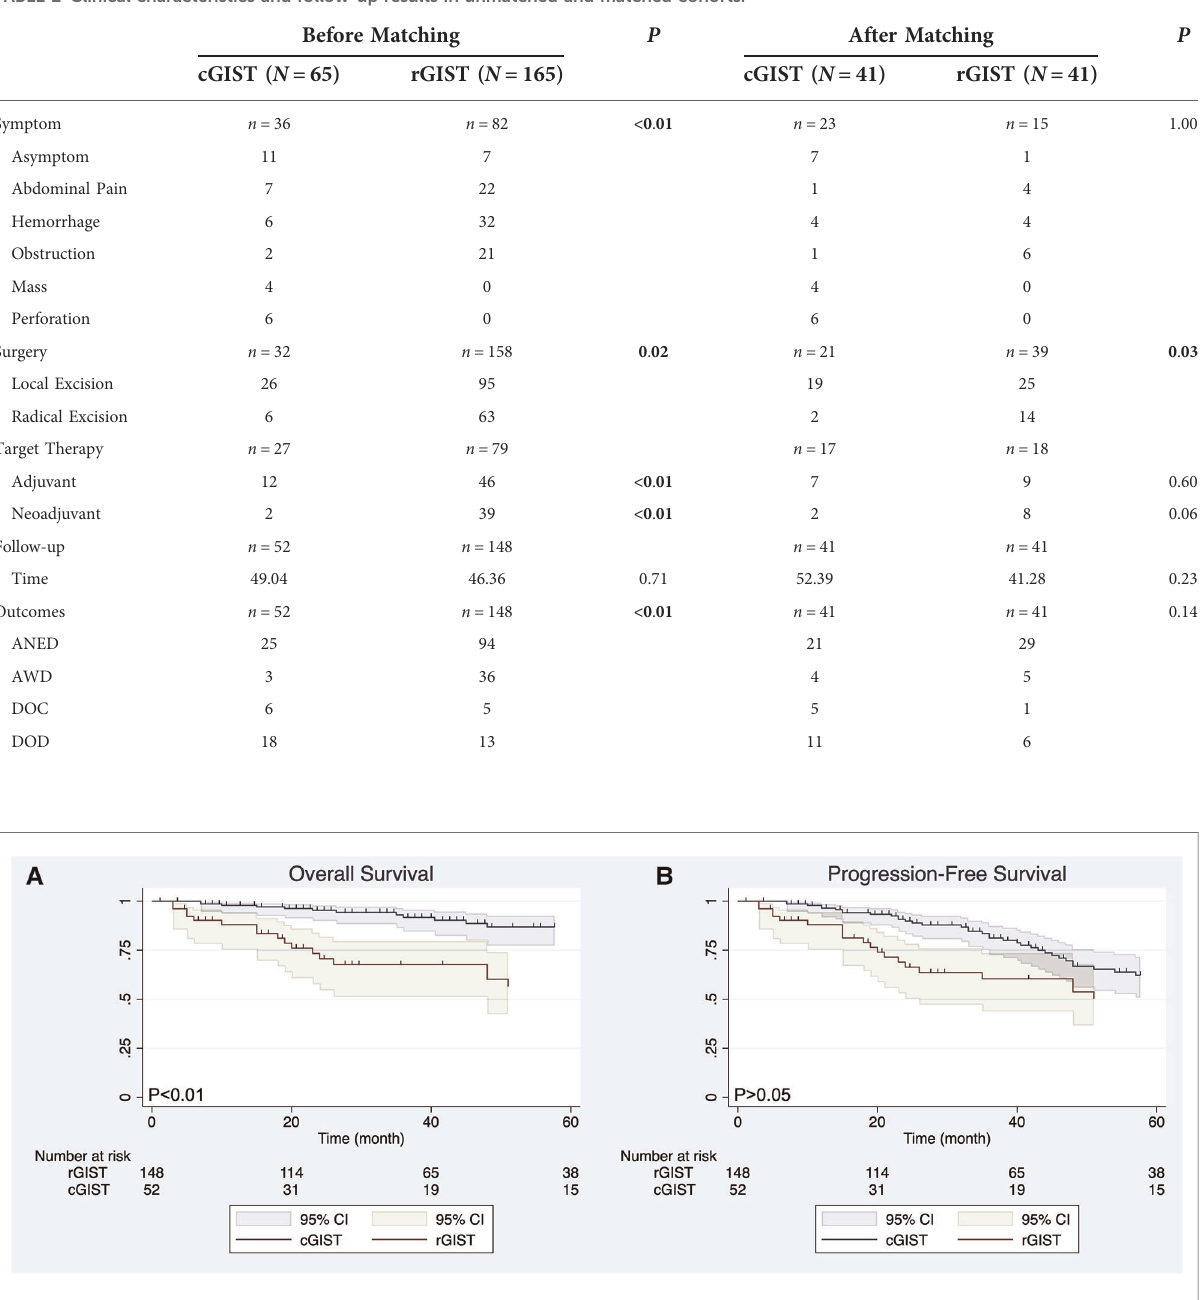
FIGURE 2 Overall survival ( A ) and progression-free survival ( B ) of cGIST and rGIST before propensity score matching.